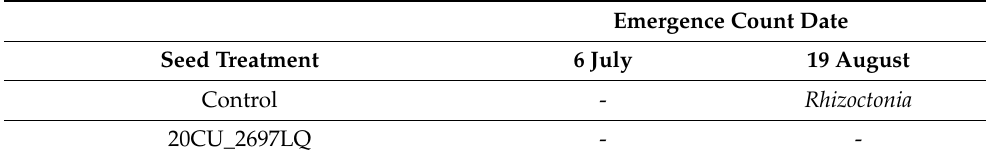
Figure 2. Pathogens were observed on seedlings from treatments 1, 3, 4 and 5 and 9 (Tables 1 and 6). Damping-off pathogens were identified as P. aphanidermatum, F. equiseti, F. solani, F. oxysporum, R. solani , Mucor , and Trichoderma species (Table 6) and the presence of bacterial species was also identified on hemp seedlings from trial 1 in NY. Pathogen tests were conducted in the Bergstrom lab, Cornell University. Table 6. Sample and positive identification of pathogens present on hemp seedlings in Ithaca, NY. Table 7. Sample and positive identification of pathogens present on hemp seedlings in Prosper,